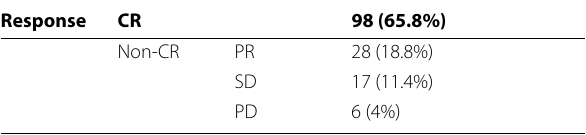
Table 3 Response to TACE in all lesions